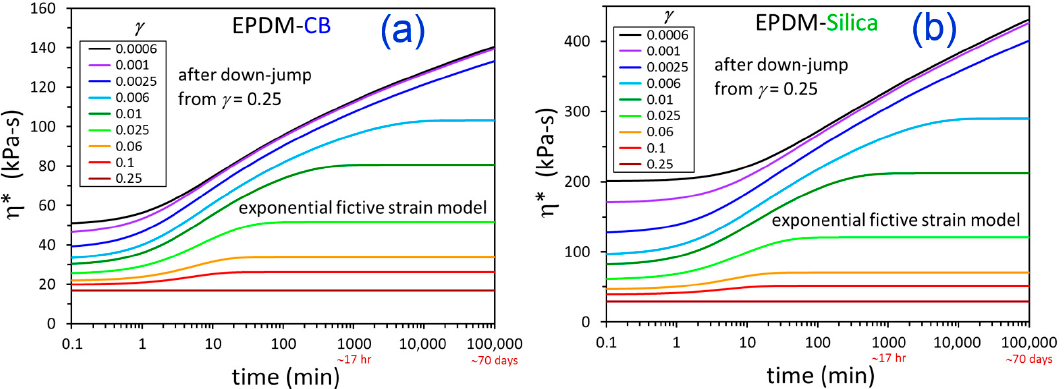
Figure 10. Predicted η * vs. time at the indicated strain amplitudes for EPDM-CB ( a ) and EPDM-Silica